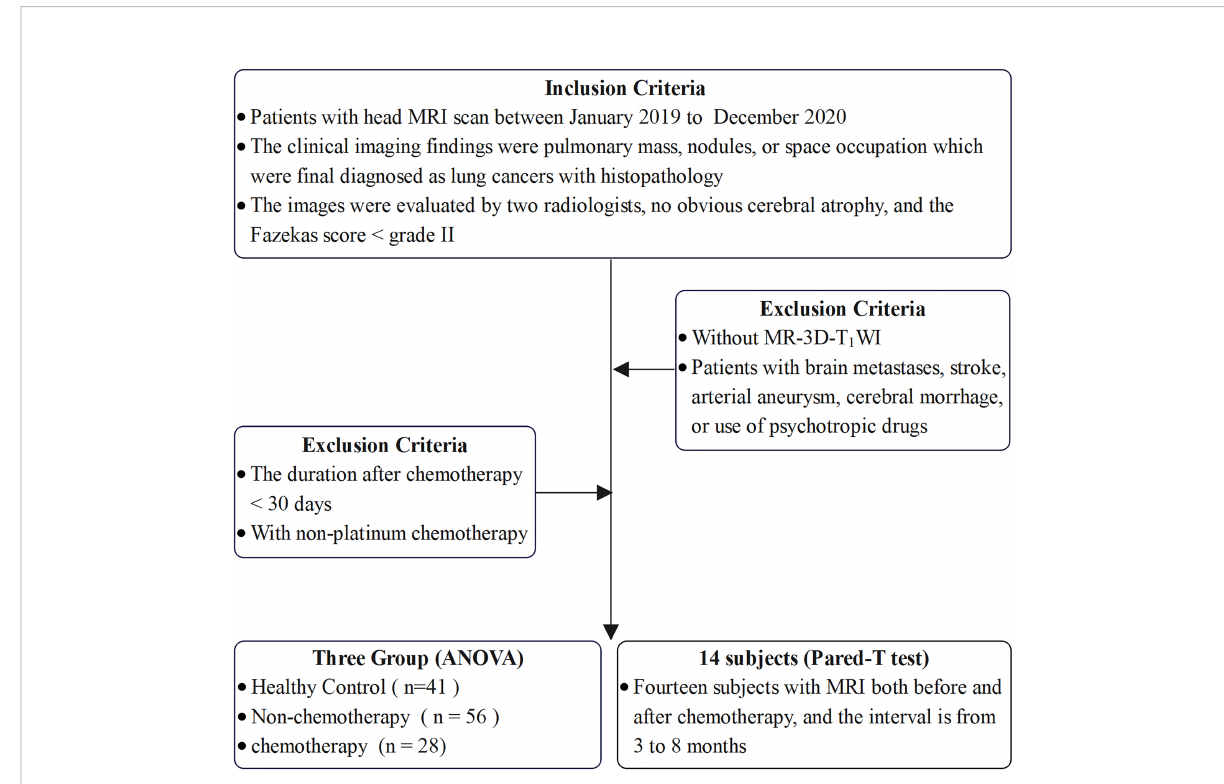
FIGURE 1 Flow diagram of the inclusion criteria for the study